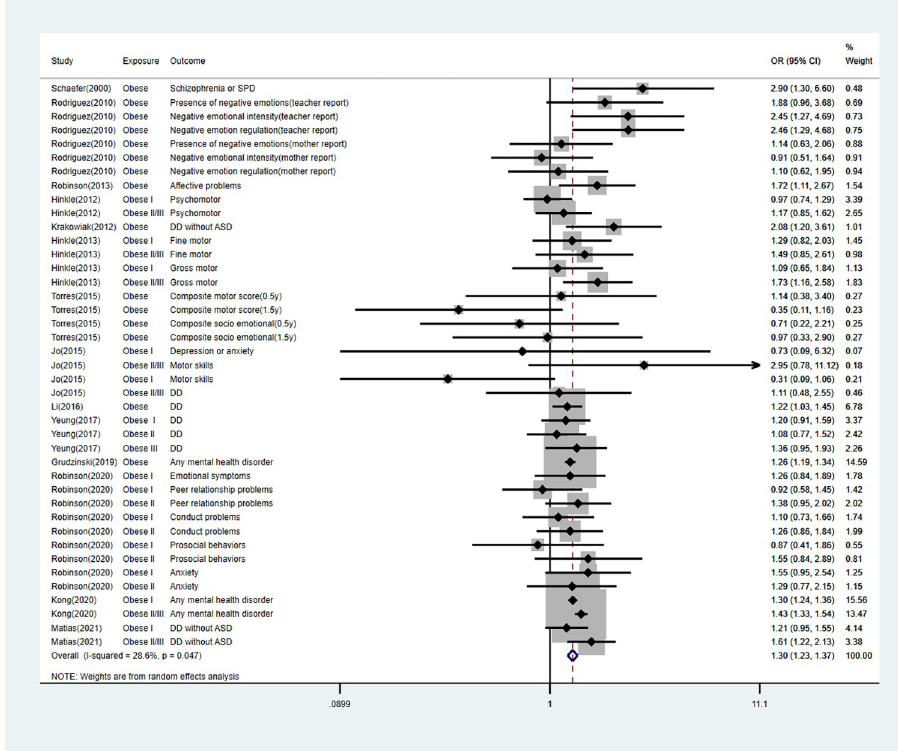
Fig 7. Forest plot for obese mothers and their offspring’s risk of other mental diseases.